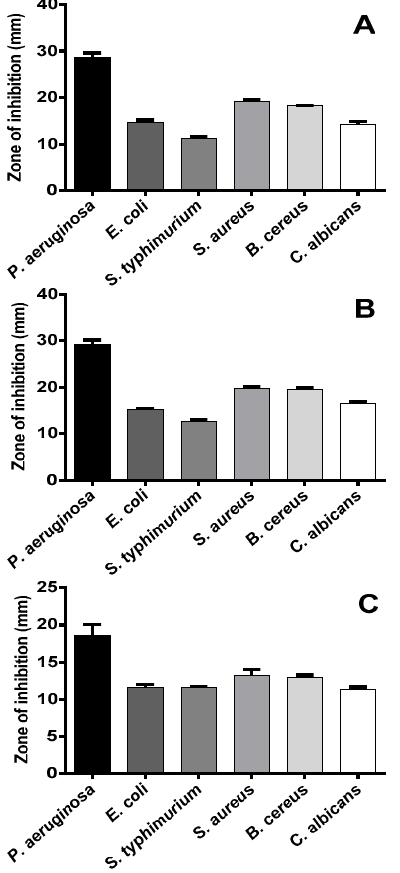
Figure 2. Antimicrobial activity of 400 μ g of kino extract from ( A ) Corymbia citriodora , ( B ) C. torelliana × C. citriodora , and ( C ) C. torelliana against six microorganisms. Zones of inhibition are presented as mean + S.E. ( n = 21 trees for C. citriodora and the hybrid; n = 3 trees for C. torelliana ). Means among the three kino extracts do not differ significantly (ANOVA, p > 0.05).